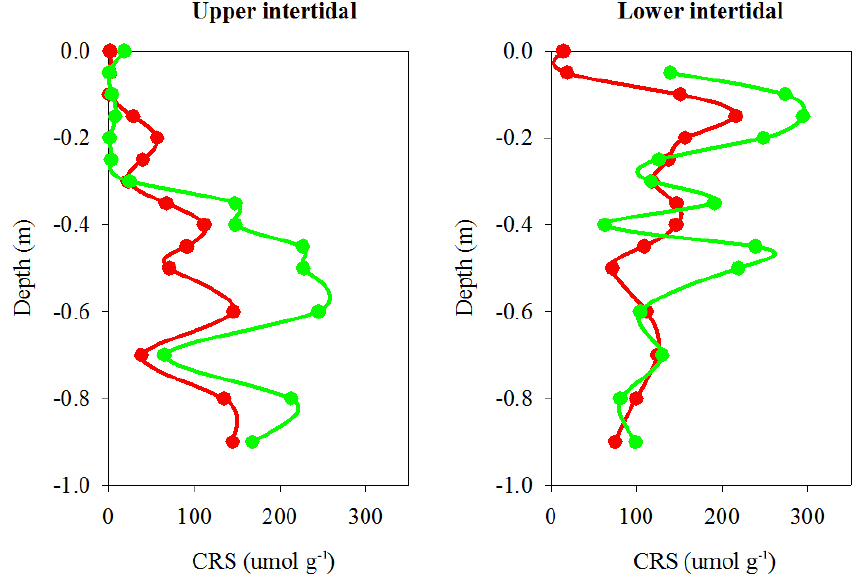
Figure 6. Chromium reducible sulfur (CRS) profiles (a proxy for pyrite) from sediment cores in dead (red) and living (green) mangrove areas in the Gulf of